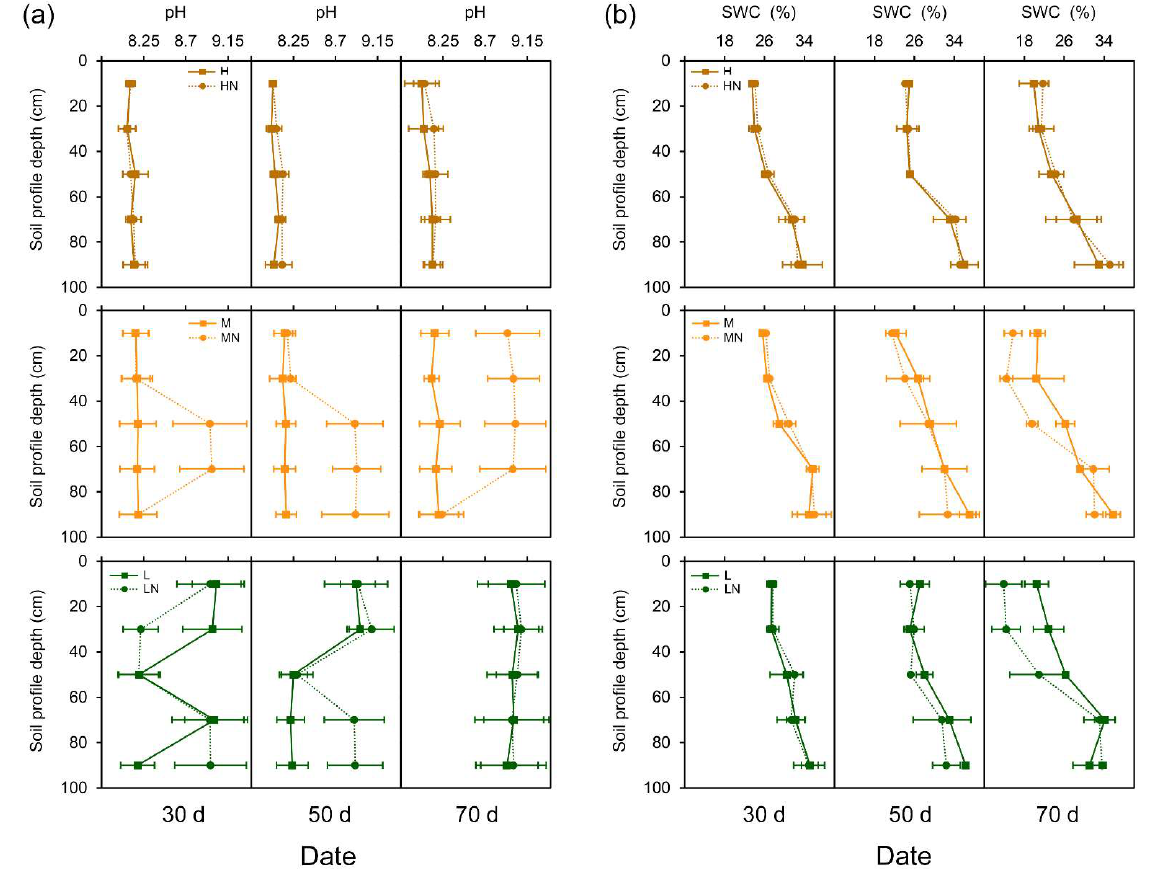
Figure 2. Soil pH ( a ) and water contents (SWC) ( b ) in the soil profile (0–100 cm) during the experi- mental periods.